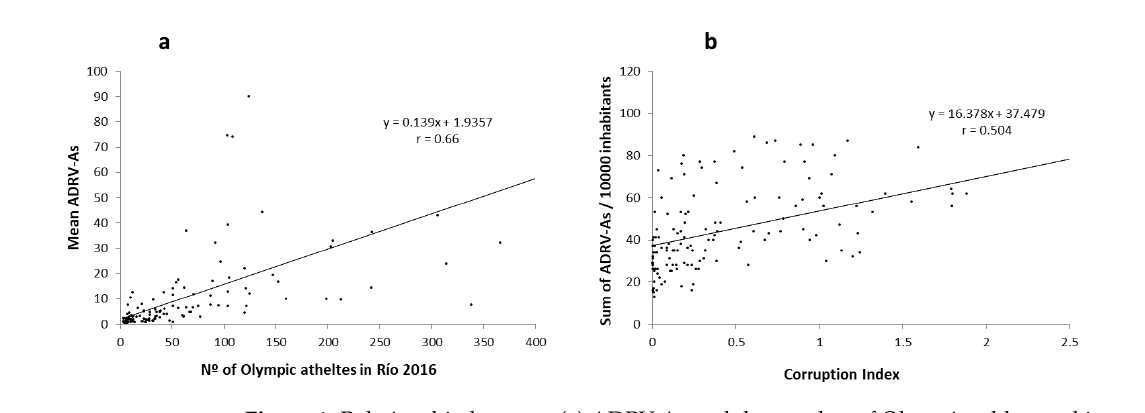
Table 3. Regression equations to predict ADRV-as based on socioeconomic parameters.